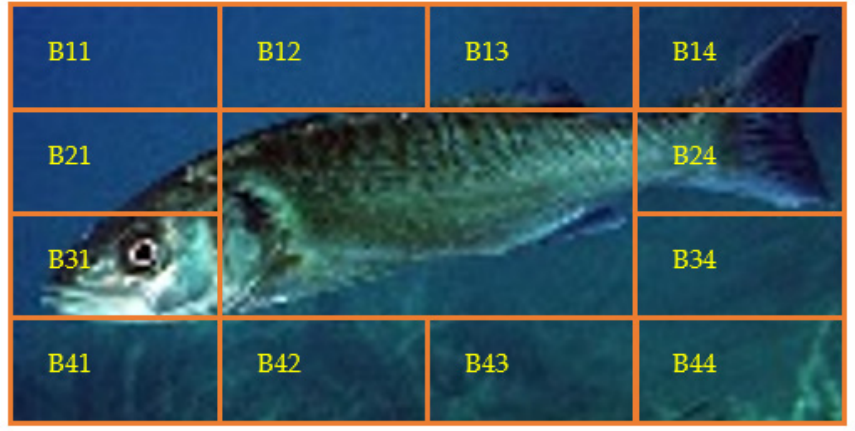
Figure 2. Segmentation for the validation of the “Contour1 + Colored Regions” path.